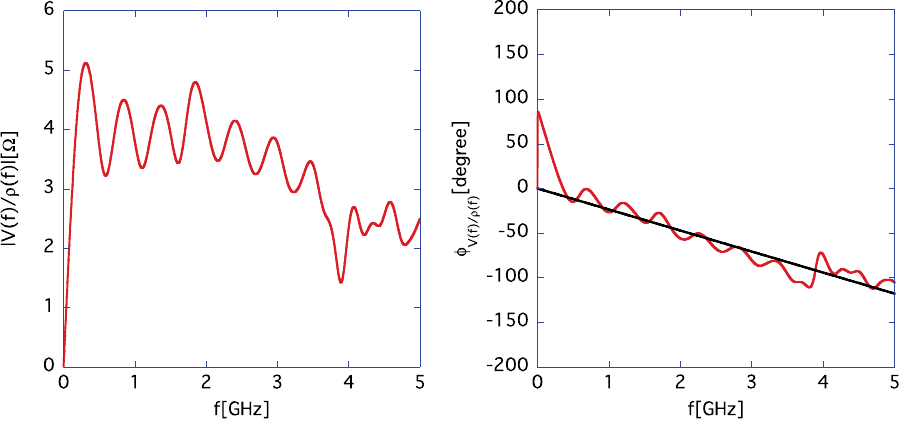
FIG. 9. Fourier transform of the beam induced-voltage divided by that of the beam current for the triangle